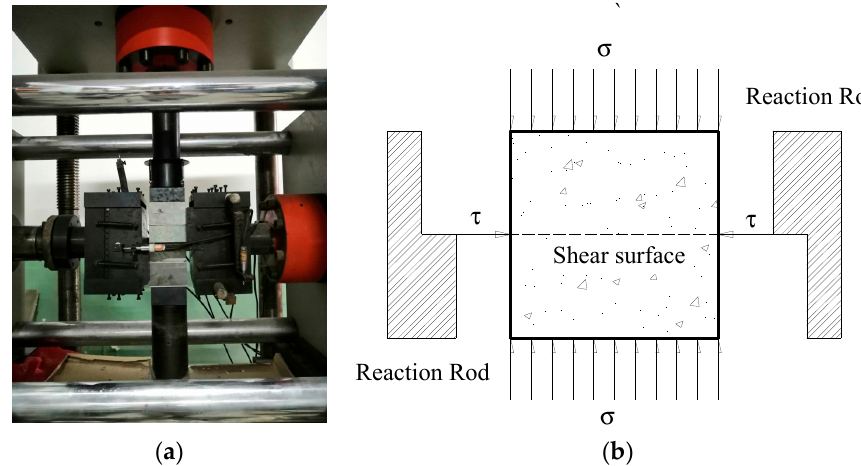
Figure 1. A schematic diagram of compression-shear loading equipment and loading method: ( a ) Loading equipment; ( b ) Sketchy picture of loading method.